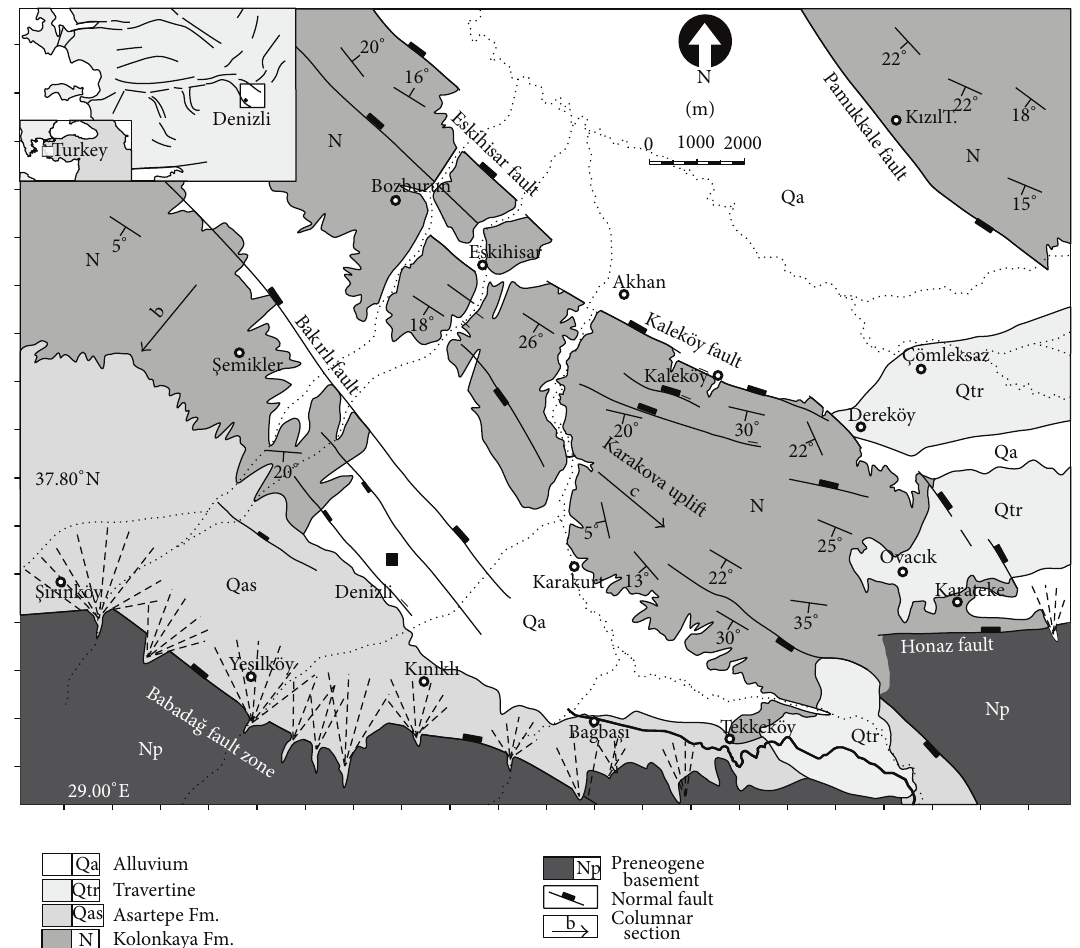
Figure 1: Generalization tectonic features and location study area (modified from [34,